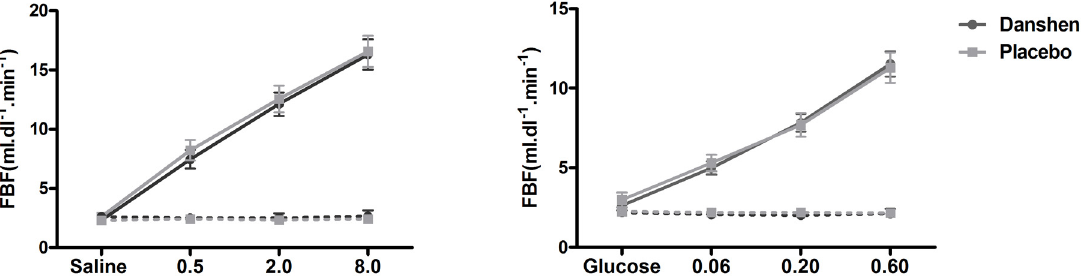
Fig 4. Results of the Nijmegen Hemostasis Assay. A. Thrombin generation. B. Plasmin generation measured by fibrinolysis time.